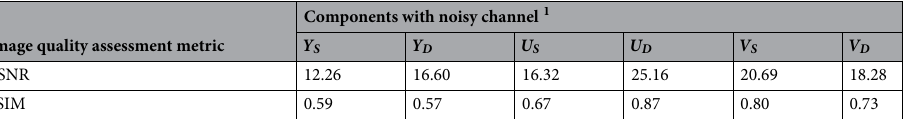
1 Parameters: p =0.01.